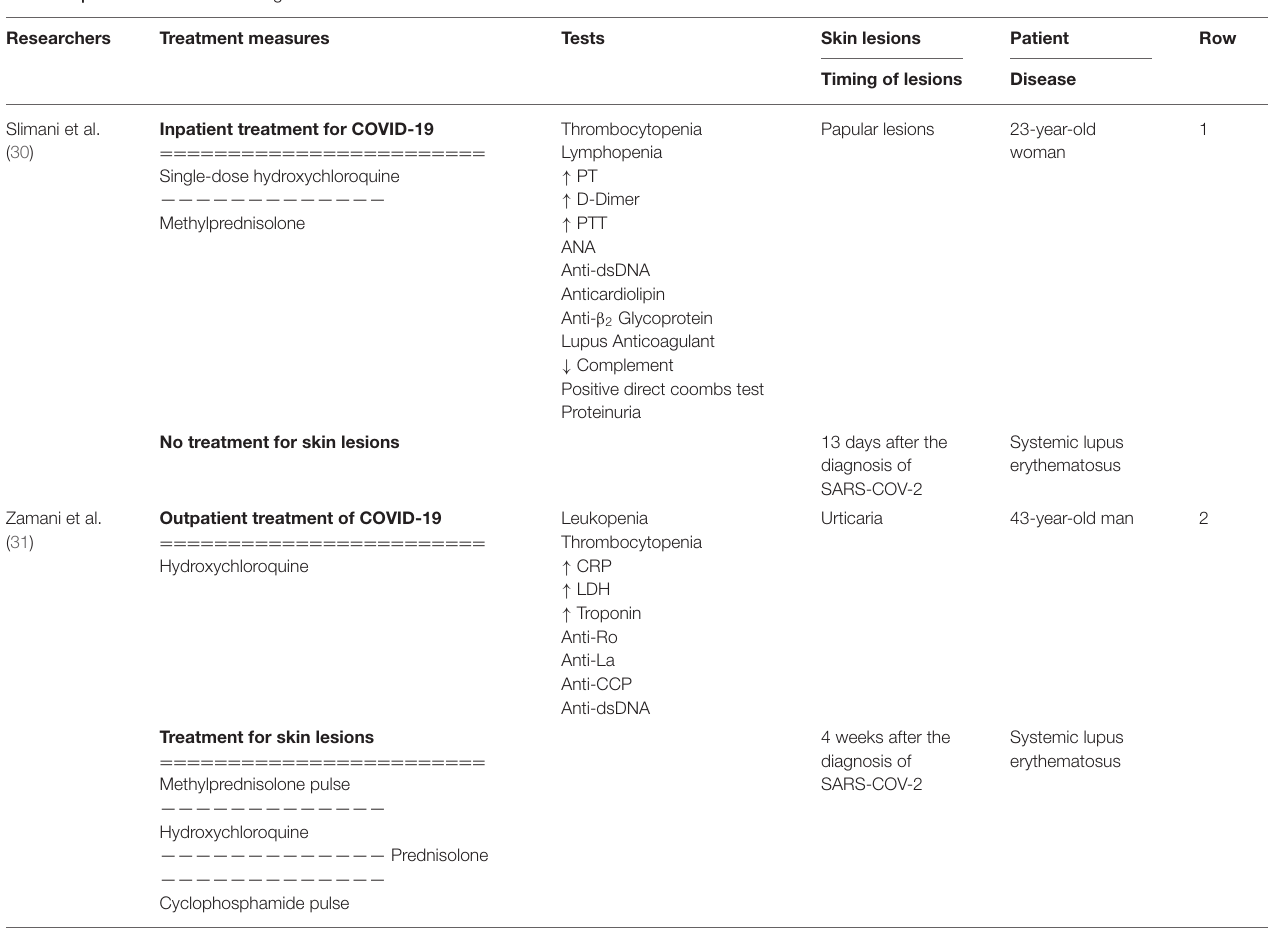
TABLE 2 | COVID-19-induced collagen-vascular